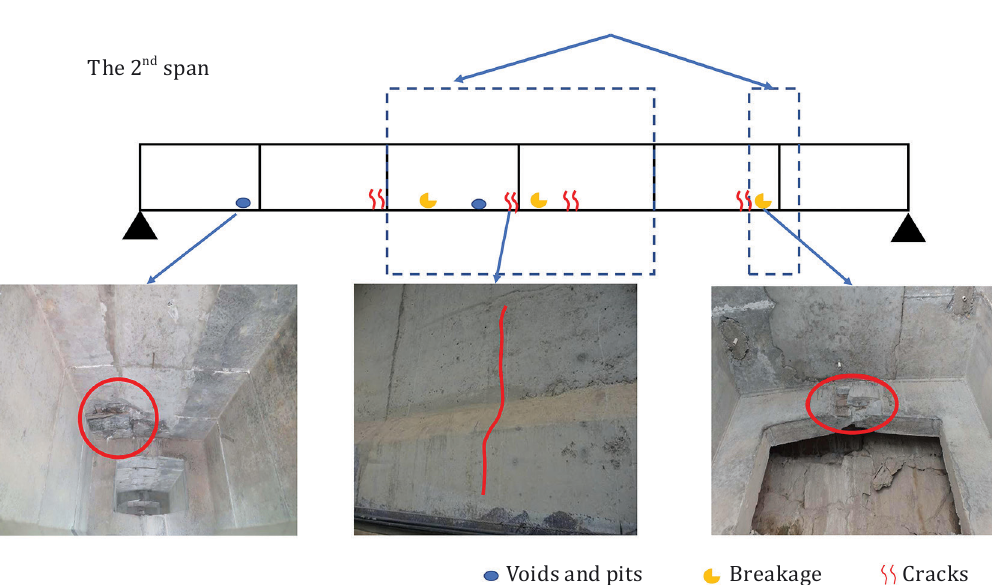
Figure 15. Identified damage location and detected damage